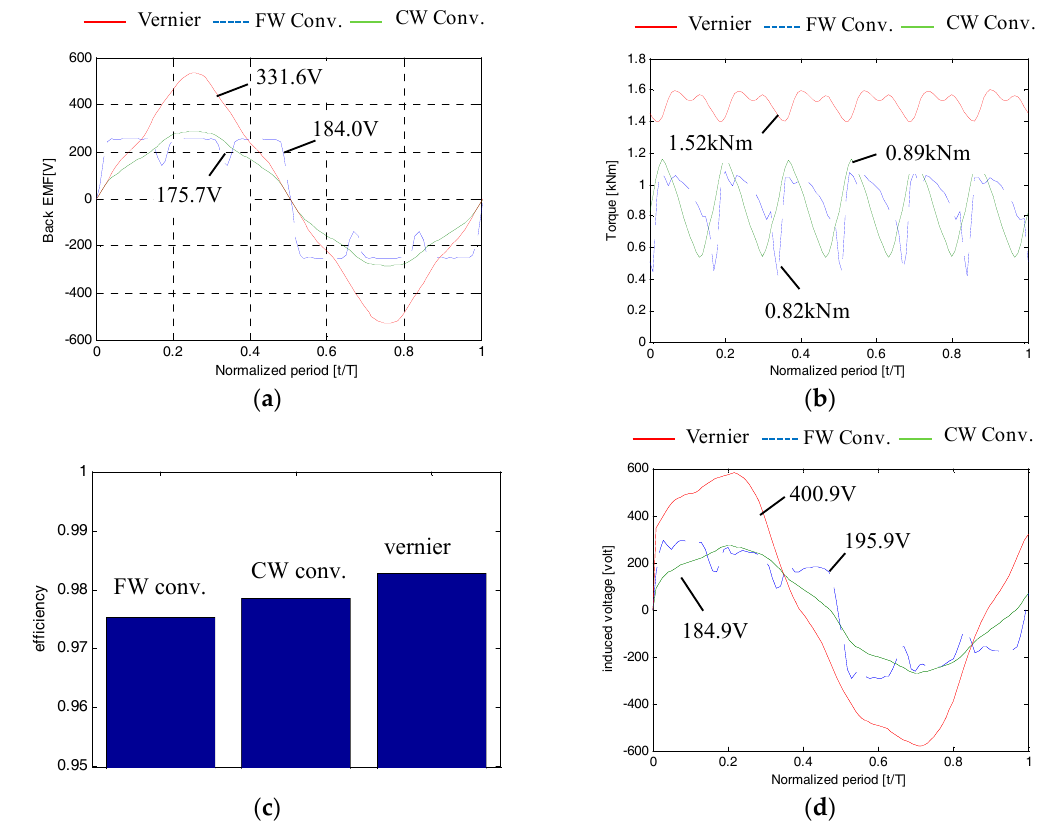
Figure 10. No-load back EMF and torque characteristics of the analysis models. ( a ) No-load back EMF and RMS value; ( b ) Toque and average value; ( c ) Efficiency; ( d ) Induced voltage and RMS value (with load current).